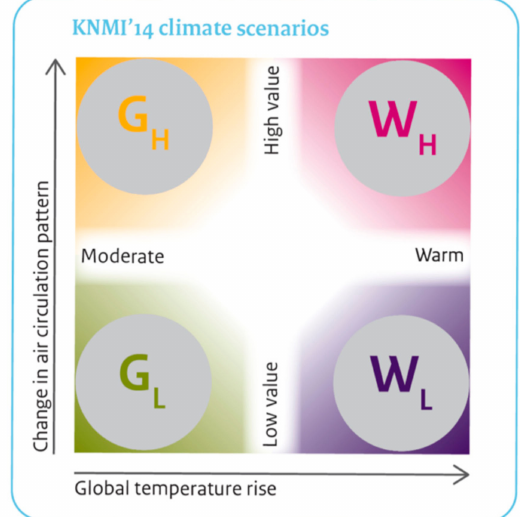
Figure 2. Four scenarios were used to calculate future heat stress. They differ in global temperature rise and change in air circulation pattern. Reproduced with permission from KNMI, Brochure KNMI’14 climate scenarios, 2015